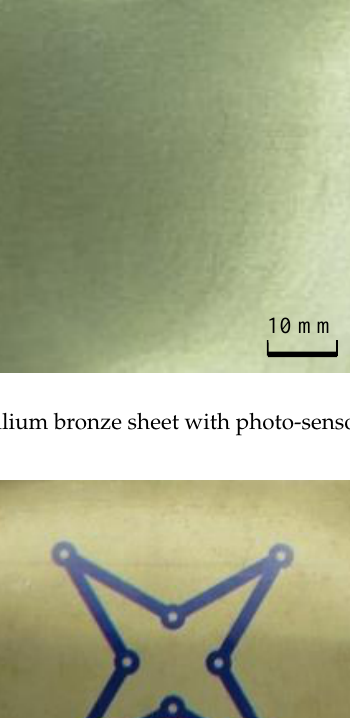
Figure 5. Beryllium bronze sheet with photo-sensory membrane.